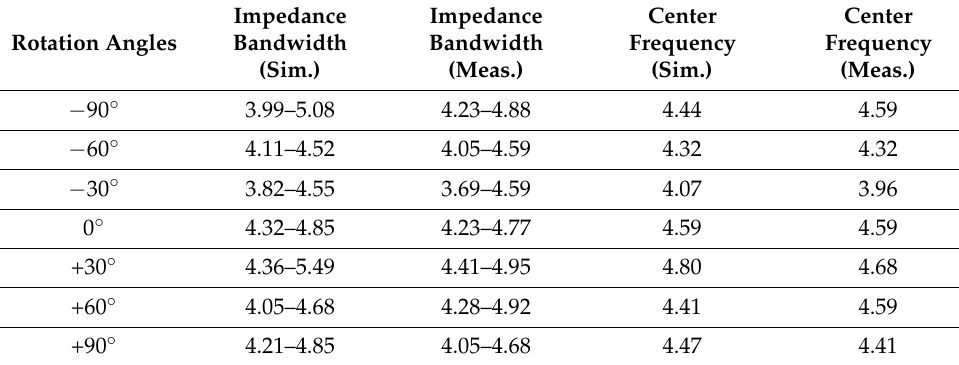
Table 2. The impedance bandwidth and the center frequency for different rotation angles. Impedance Rotation Angles Bandwidth